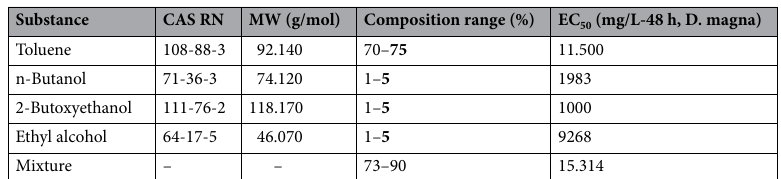
Table 2. Composition and toxicity data of mixture components in SDS, and EC 50 of mixture predicted by the simple CA model for Case Study 2.